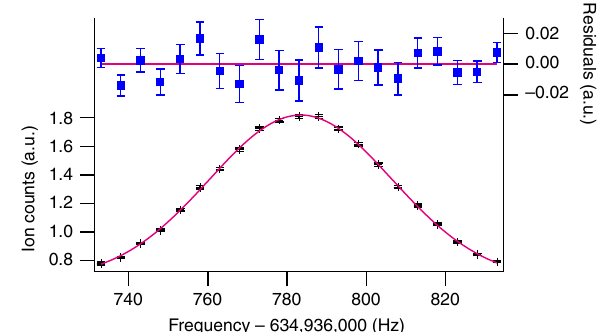
Fig. 3 Typical spectrum of the |i 〉 − |f 〉 transition. Average of the ion signals and its standard deviations of mean (shown in black) are plotted against the microwave frequency. The total number of original data points used to make this plot is ~95,000, which corresponds to 6 h of data collection. To fi nd the central frequency, the spectrum is fi tted to a Gaussian function (magenta curve). Subtracting the Gaussian function from the ion counts gives the clear view of the residuals. The full-width-of-half-maximum (FWHM) of the spectrum is about 50 Hz, which is limited by the microwave pulse duration of 16 ms